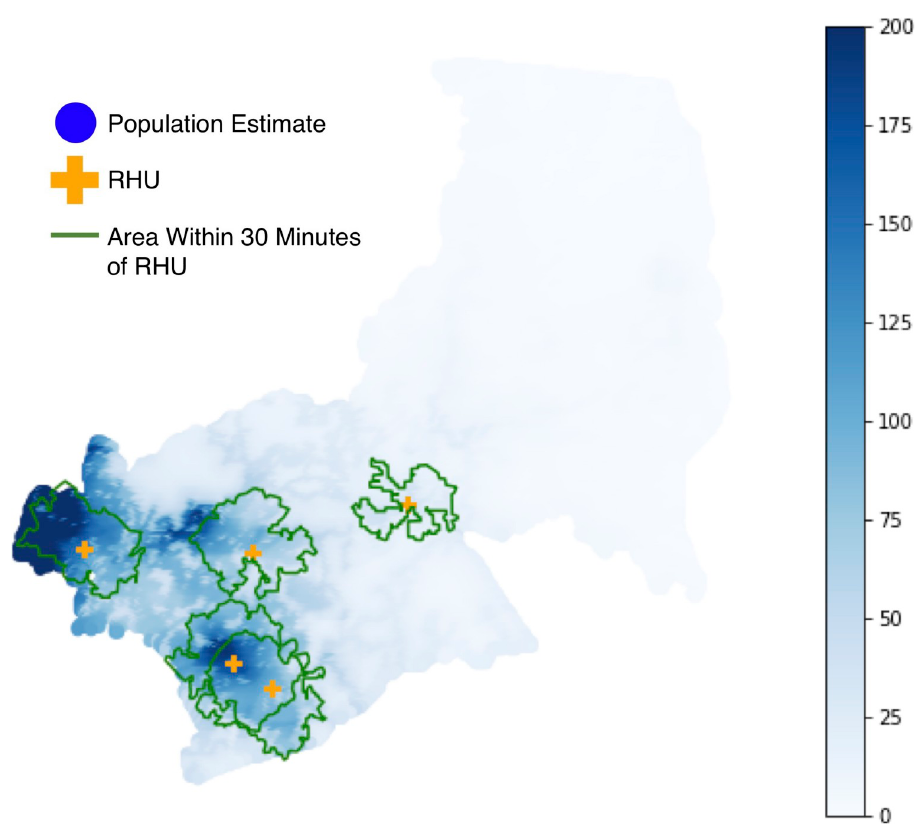
Fig 1. Overview of Antipolo